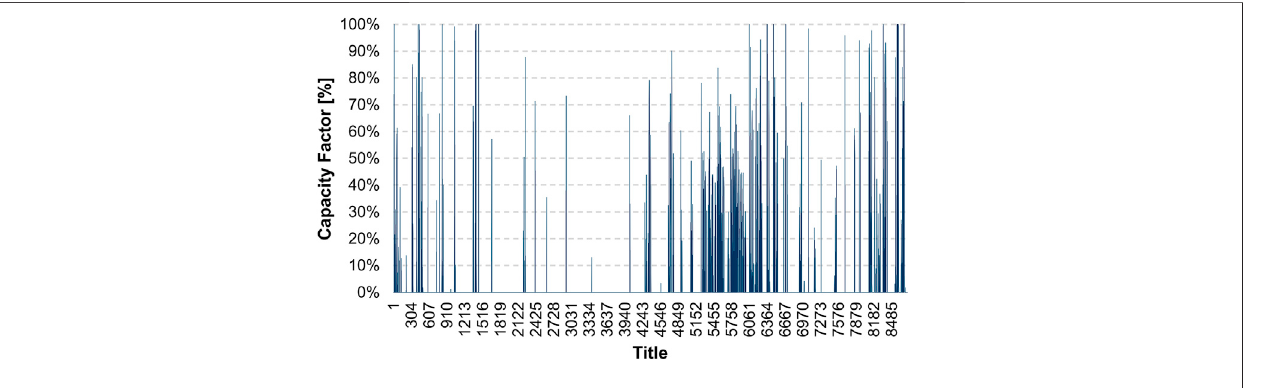
FIGURE 14 | Charging power of hydrogen OCGT storage vs. time